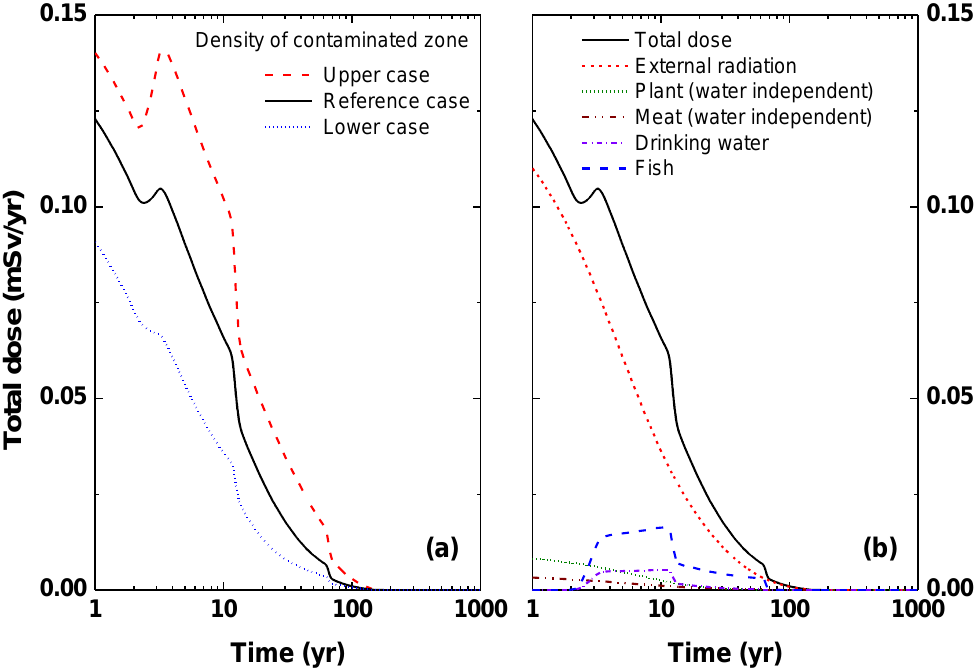
Figure 3. ( a ) Sensitivity analysis result for the density of contaminated zone and ( b ) relevant exposure pathways for the reference case. Minor pathways are not shown.